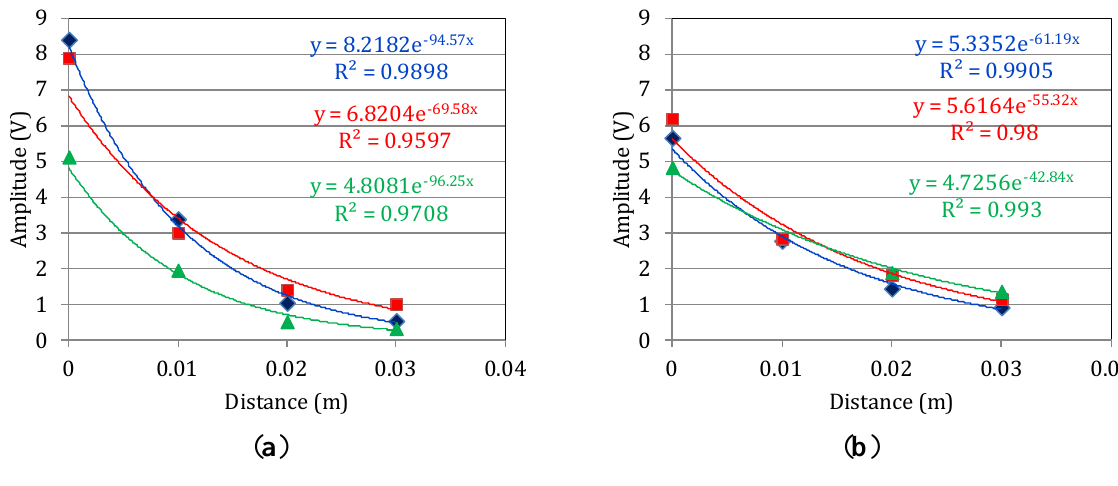
Figure 4. Amplitude vs . propagation distance curves for attenuation